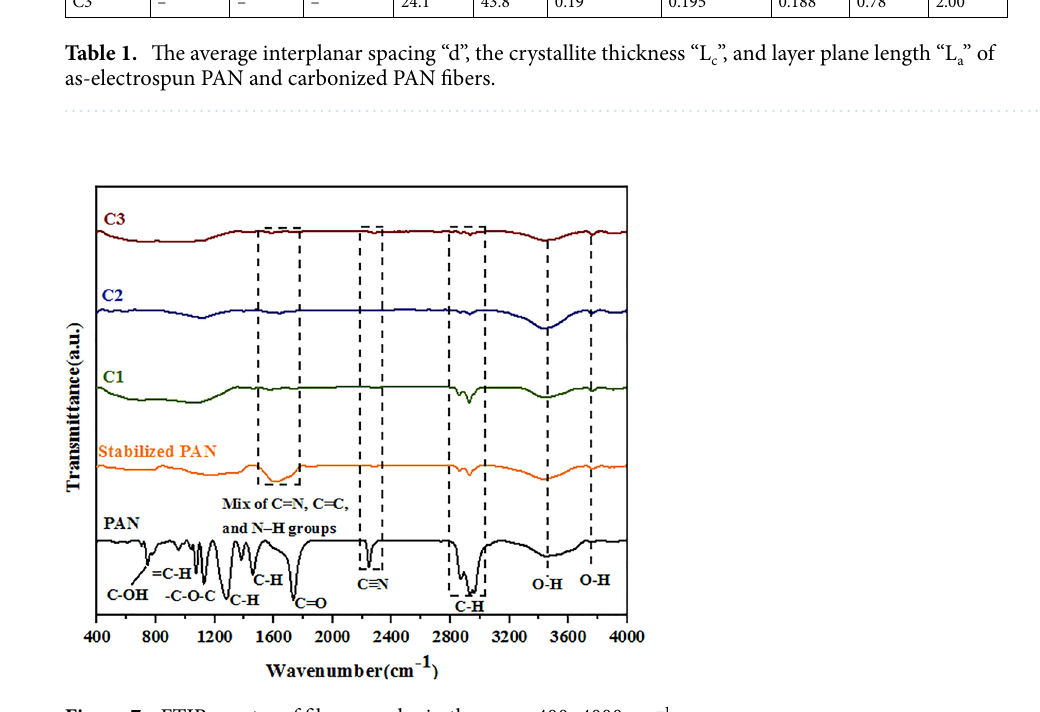
Figure 7. FTIR spectra of fiber samples in the range 400–4000 cm −1